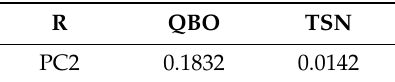
Table 14. Correlation coe ffi cients (R) between PC2 and the low-frequency climate indices (bold font indicates statistically significant values at the 5%